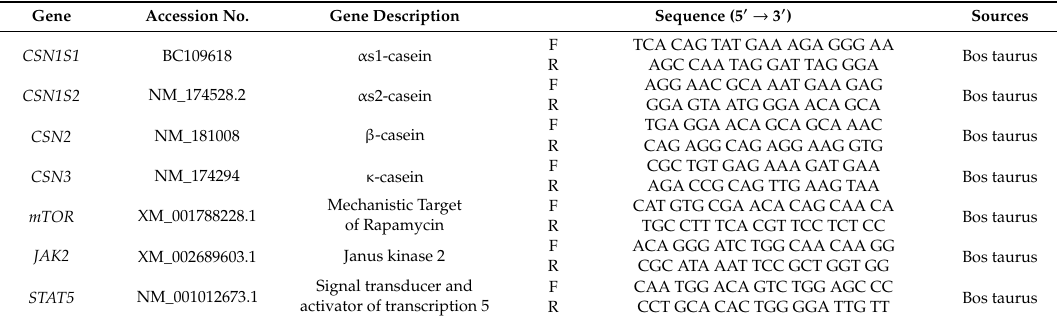
Table5. Primersforreal-timePCRanalysisoftargetgenesandcaseininbovinemammaryepithelialcells. Gene Accession